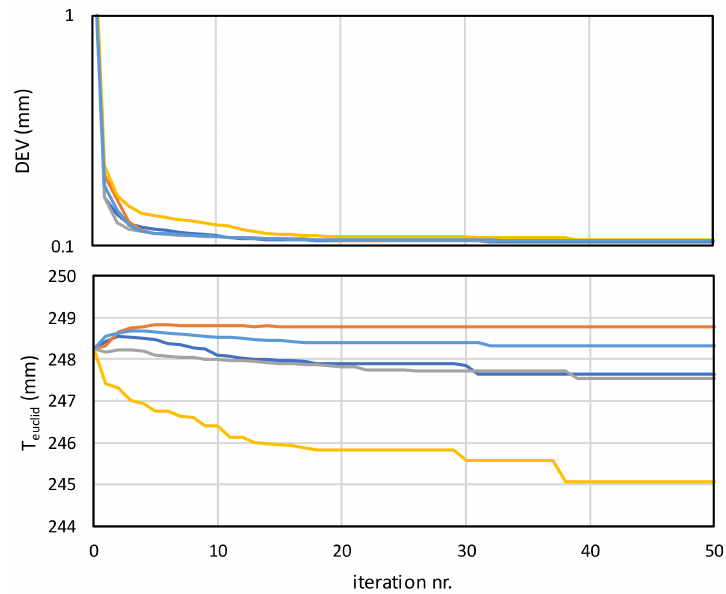
Figure 11. Convergence plot of the merit function (DEV) value and Euclidean distance of hand–eye translations (T euclid ) during numerical optimization of the transformation parameters. Five curves represent repetitions of calibration measurements with different hand–eye configuration.